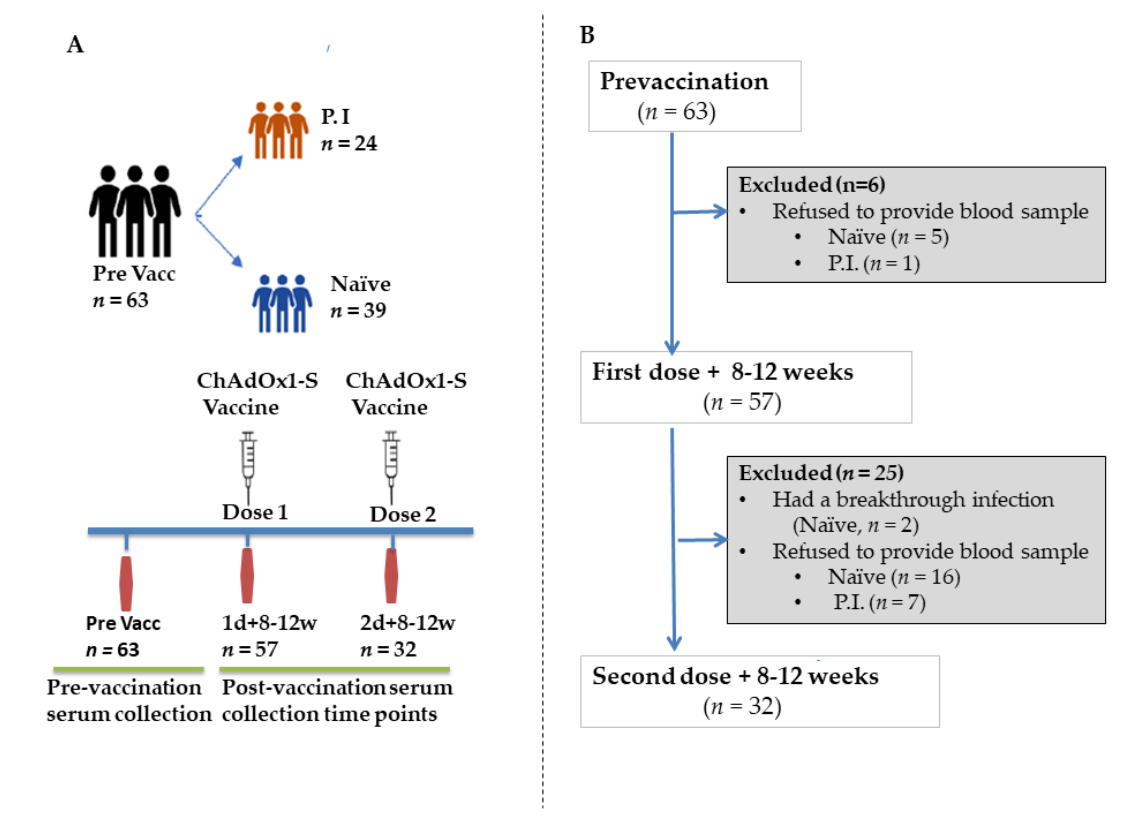
Figure 1. Cohort study design showing the ChAdOx1 nCoV-19 vaccine vaccination regimes and serum sample collection time points: ( A ) Study design with a timeline for vaccination and blood sam- ple collection. ( B ) Schematic representation of the number of participants enrolled at prevaccination and two post-vaccination time points. The first dose and second dose were given to participants prior to the two-time points for blood sample collection. Light red characters (Naïve) represent participants immunologically naïve to SARS-CoV-2 and blue characters (P.I.) represent participants with likely previous SARS-CoV-2 infection. Pre Vacc = baseline or prevaccination; 1d + 8–12w= 8–12 weeks after the first dose; 2d + 8–12w = 8–12 weeks after the second